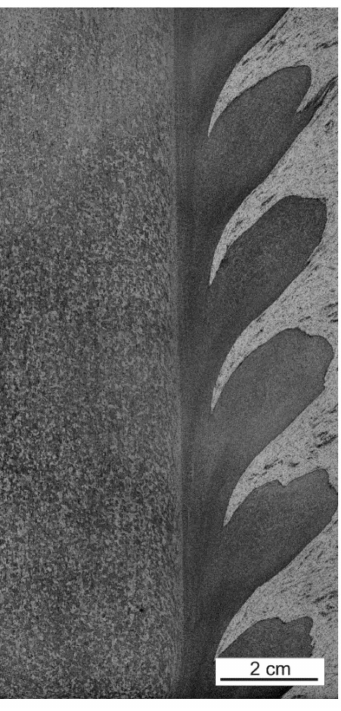
Figure 7. Zone A after the GHE histogram equalization. The differences between the surrounding and the welding layers can be observed.